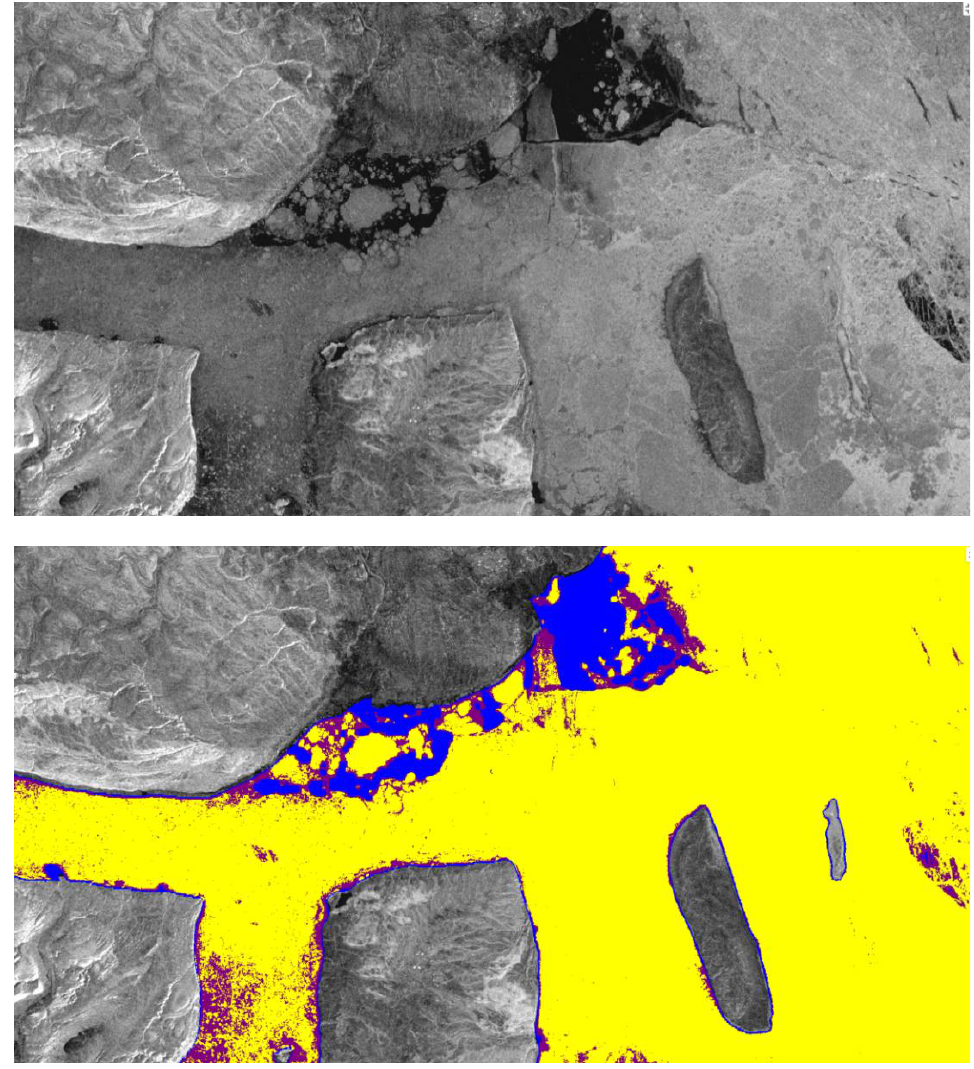
Figure 3. ( TOP ) Sentinel-1 acquisition (HH) taken on 11th September 2018 over North Greenland ( BOTTOM ) Corresponding, land masked sea ice classification with blue = Open water and thin ice, violet = young ice, yellow = First Year Ice.